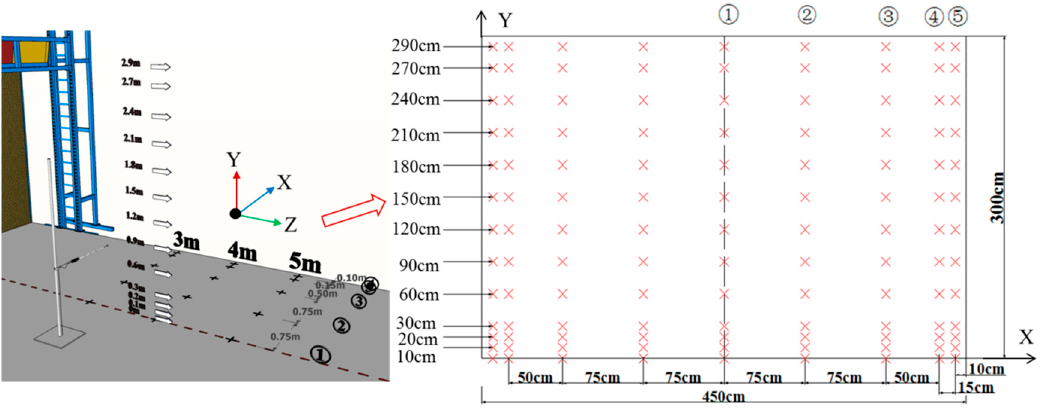
Figure 4. A sketch of the measuring method.